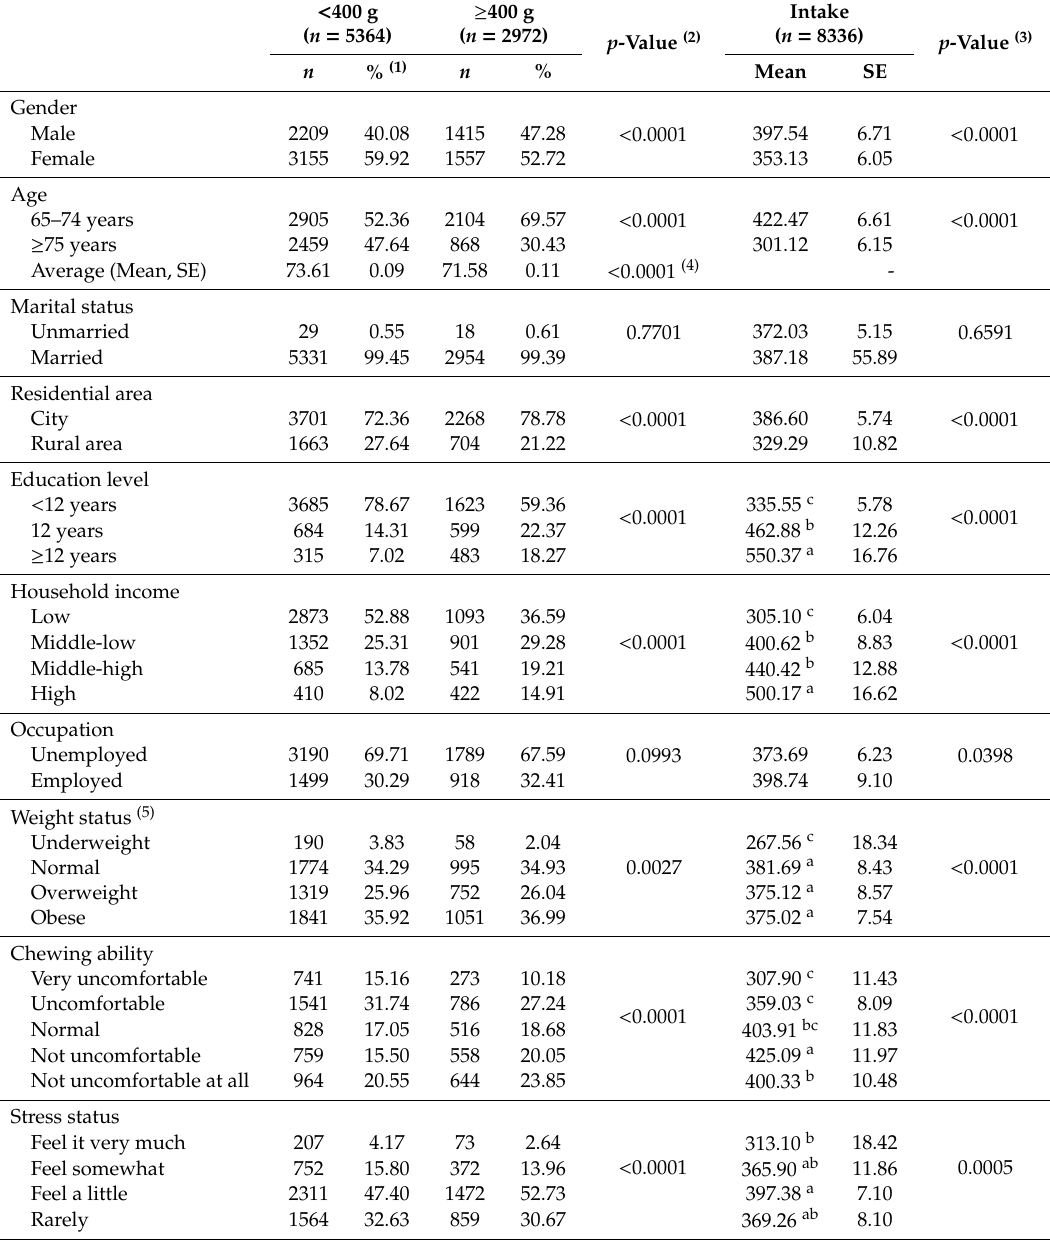
Table 2. General characteristics according to grouping of recommended fruits and vegetables